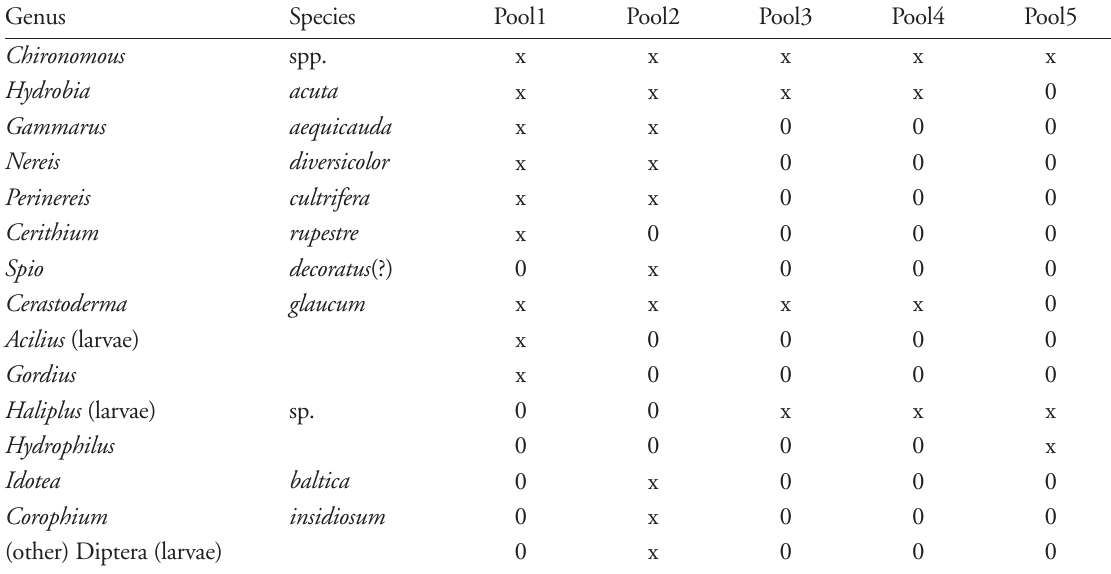
Table A1. List of sampled macroinvertebrate on Phragmites australis leaf detritus and incidence on the five sampling sta-